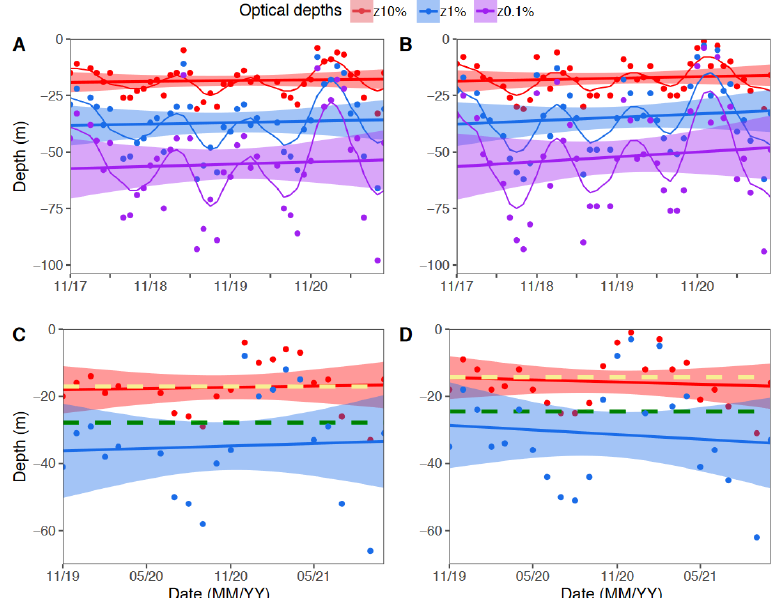
Figure 3. Monthly variation of mesophotic depths: ( A , C ) Puerto Á ngel; ( B , D ) Huatulco. Dots represent the monthly optical depths at z10%, z1%, and z0.1% in red, blue, and purple, respectively. Horizontal lines denote the 4-year average values, with 95% confidence interval area; and ( C , D ) describe the variability of the optical depths for the last two years, from 2020–2021 (same color used in the figures above for z10% and z1%), yellow and green dashed lines correspond to the maximum depths of distribution recorded for Pocillopora and Porites ,